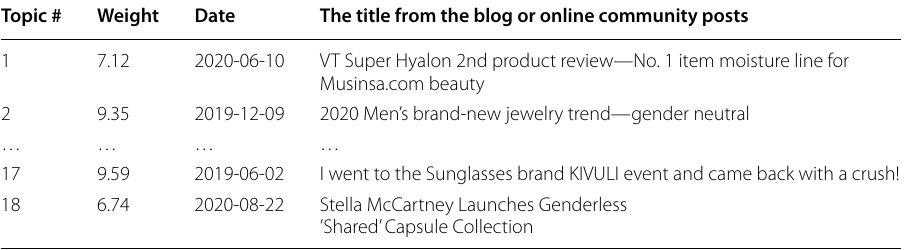
Table 2 The representative documents based on the topic weight